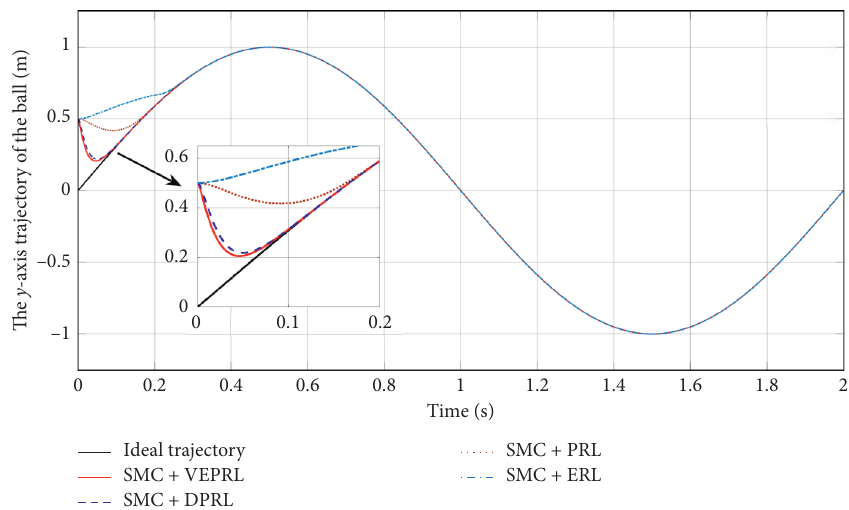
Figure 6: Comparison of y -axis tracking trajectory of the ball and plate system under SMC.